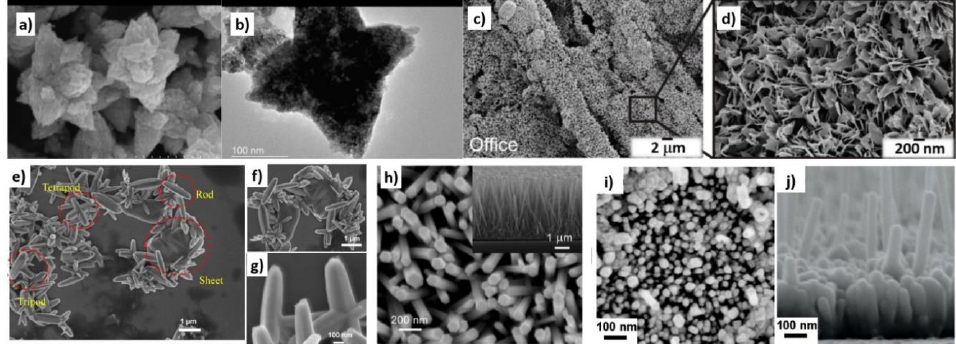
Figure 17. Examples of various ZnO structures obtained by the microwave hydrothermal synthesis: ( a , b ) Scanning electron microscopy (SEM) image and Transmission electron microscopy (TEM) image of Fe doped ZnO nanostars, respectively (Reprinted with permission from [679], Copyright © 2015